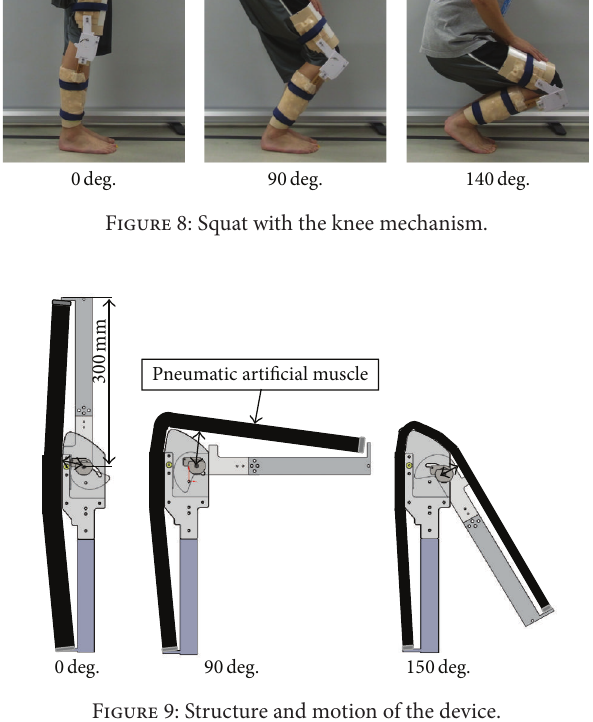
Figure 9: Structure and motion of the device.